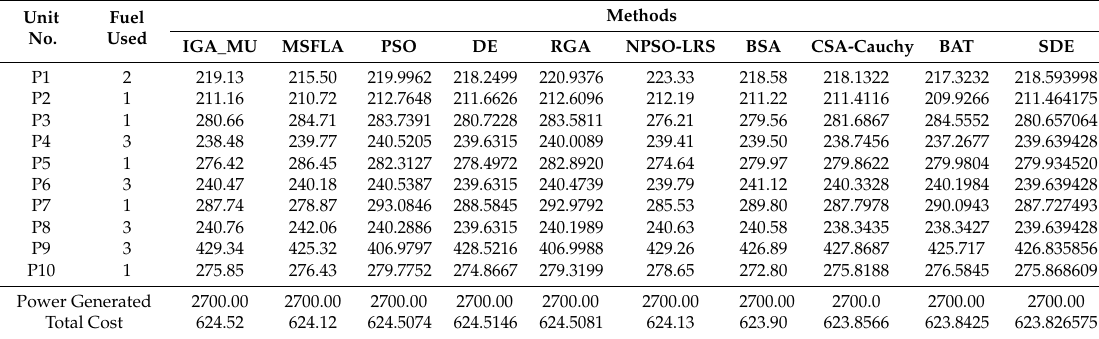
Table 7. Cost comparison among various methodologies for System 2, P d = 2600 MW. Unit